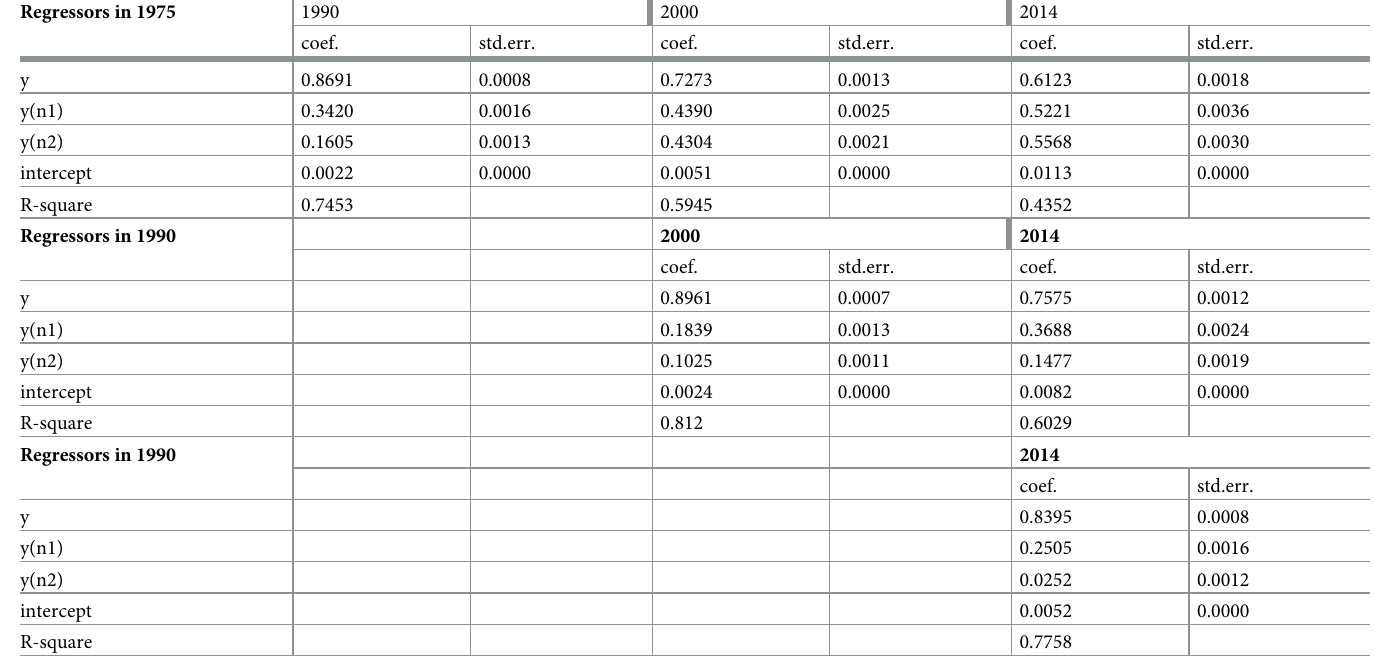
Table 8. Correlation in buildup between neighboring cells over